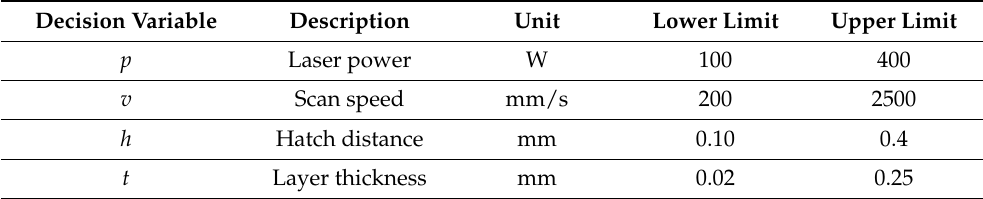
Table 3. Process parameters and their levels in the optimization